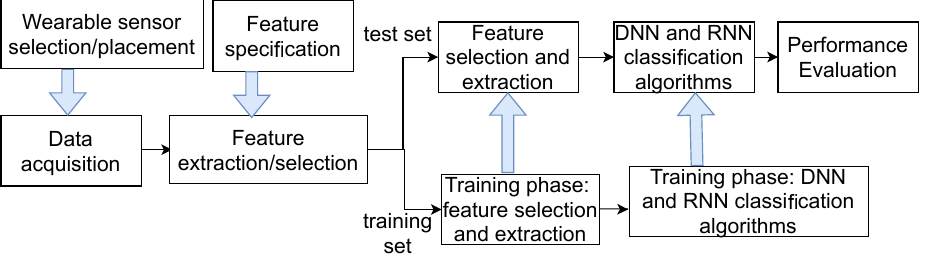
Figure 1. Research